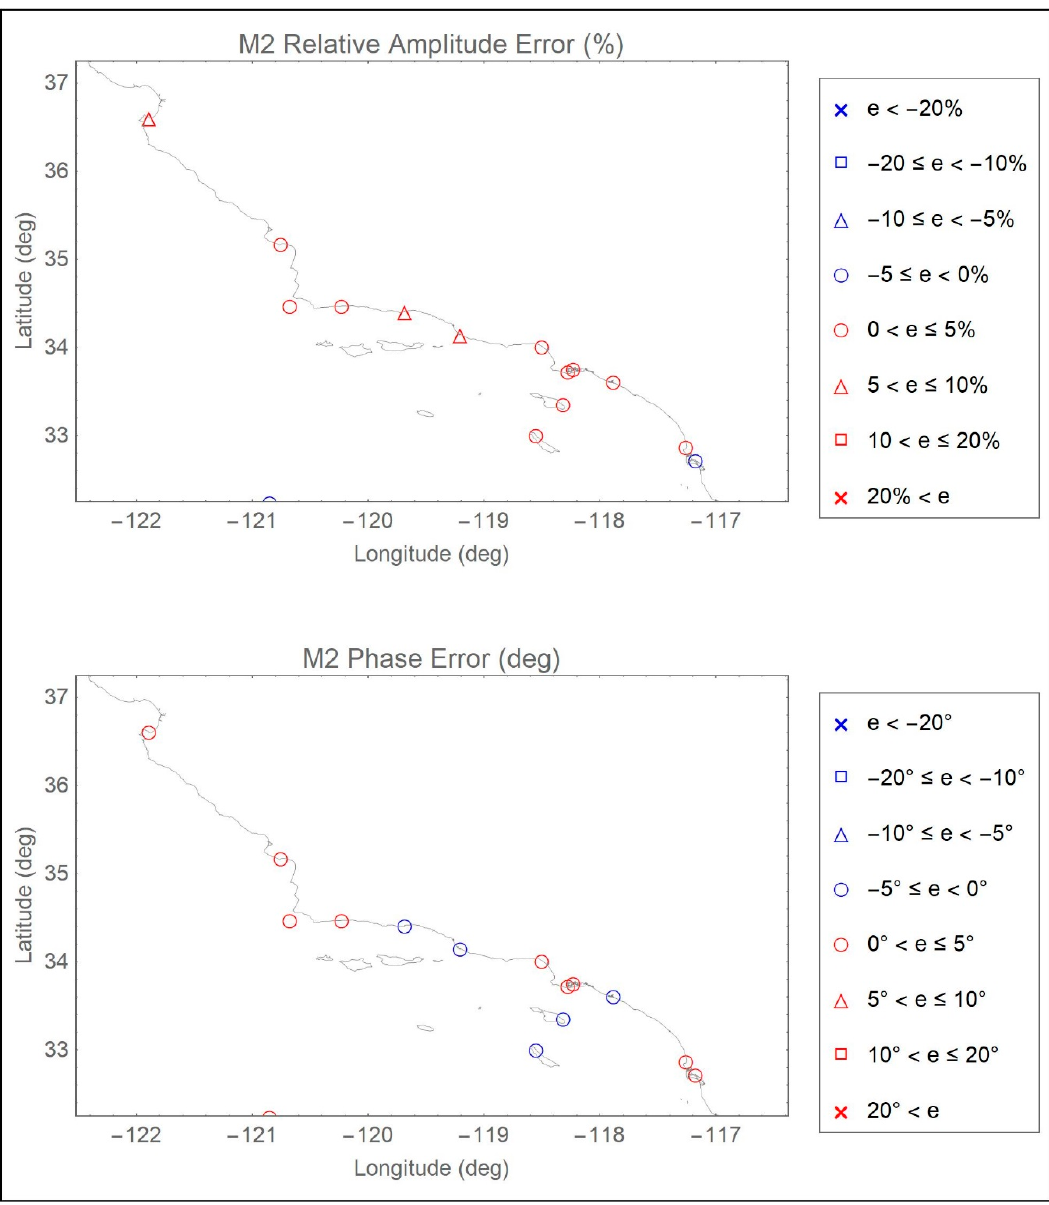
Figure A15. Distribution of ENPAC15 relative amplitude (%) and absolute phase (deg) errors for the M 2 constituent: Southern California coast view.